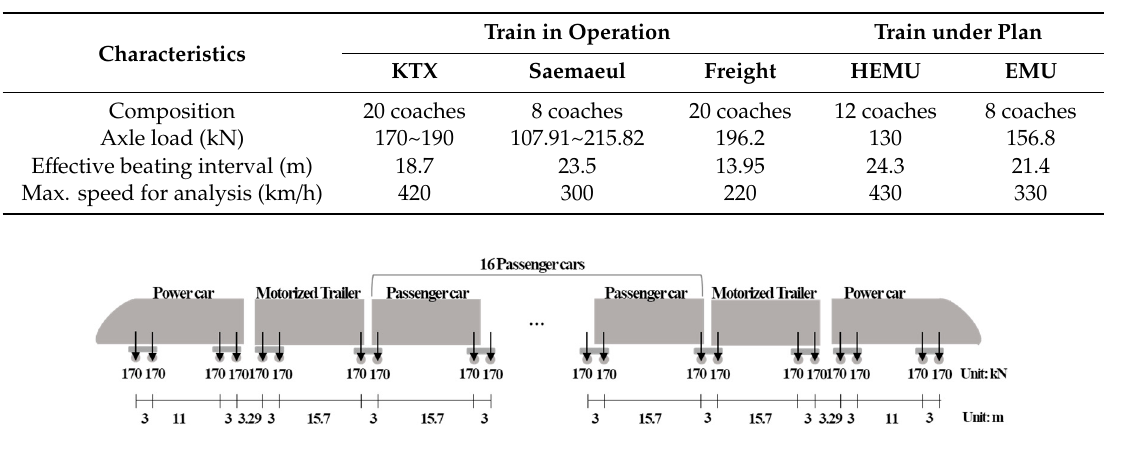
Table 4. Characteristics of trains in operation or under plan in Korea.